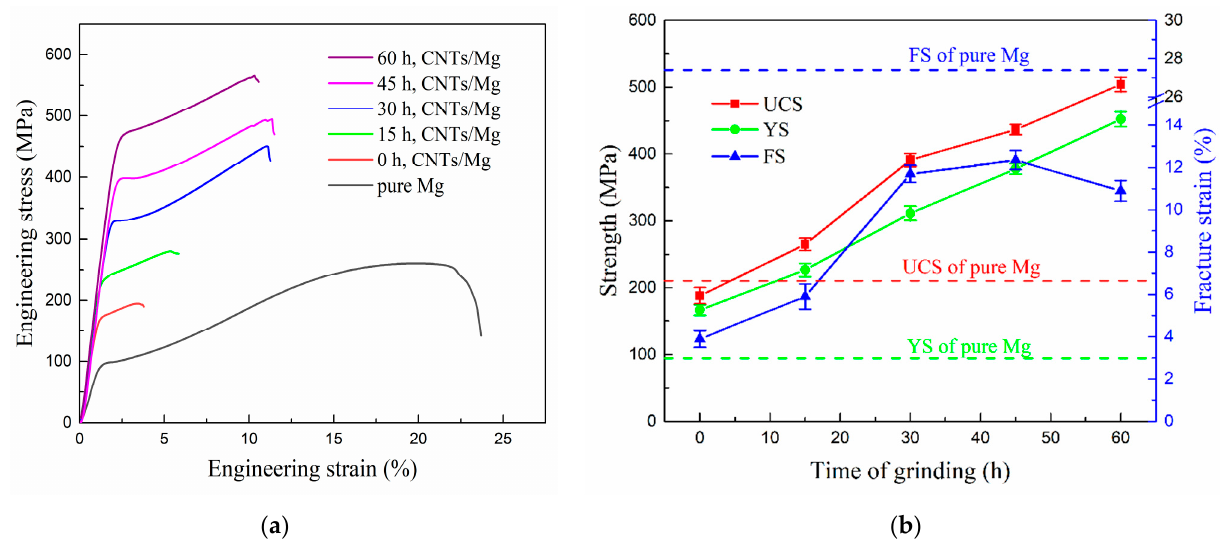
Figure 10. Effect of grinding time for magnesium powder on the compressive properties of CNTs/Mg composites. ( a ) typical engineering stress–strain curve, ( b ) strength and fracture strain.